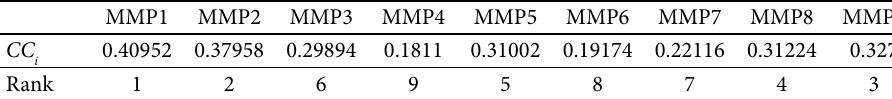
Table 14. The closeness coefficient of each